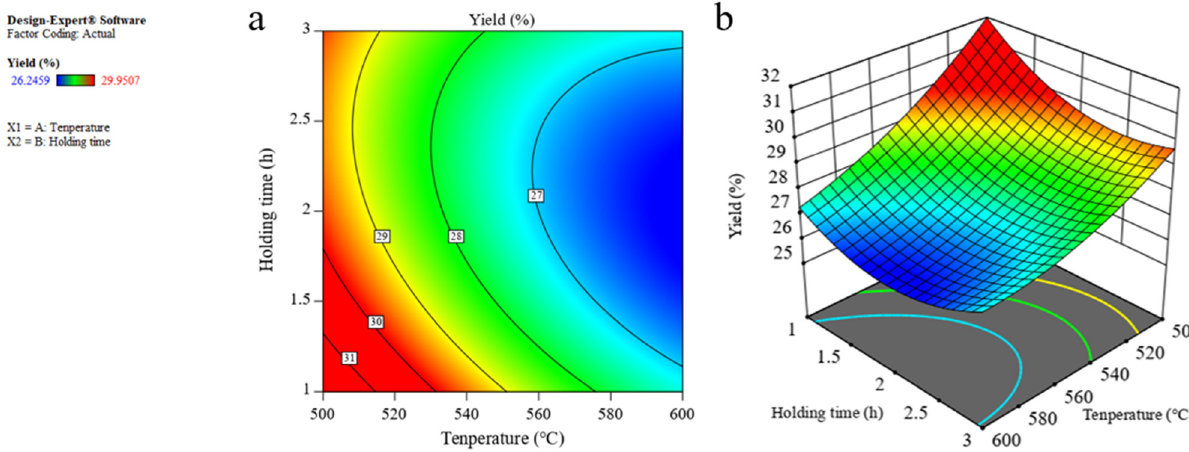
Figure 4: E ff ect of the interaction between temperature and holding time on yield. ( a ) Contour map of the e ff ect of temperature and holding time on yield. ( b ) Response surface plot of the e ff ect of temperature and holding time on yield.